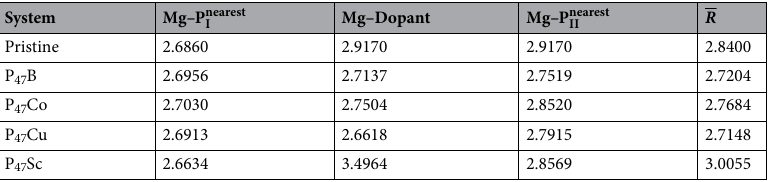
Table 1. Calculated lowest distances (in Å units) between adsorbed Mg and two phosphorene nearest atoms nearest nearest ( P I and P II ), lowest distances between adsorbed Mg and dopant (B, Sc, Co, Cu atoms), and the average distance R between Mg and three nearest substrate atoms.